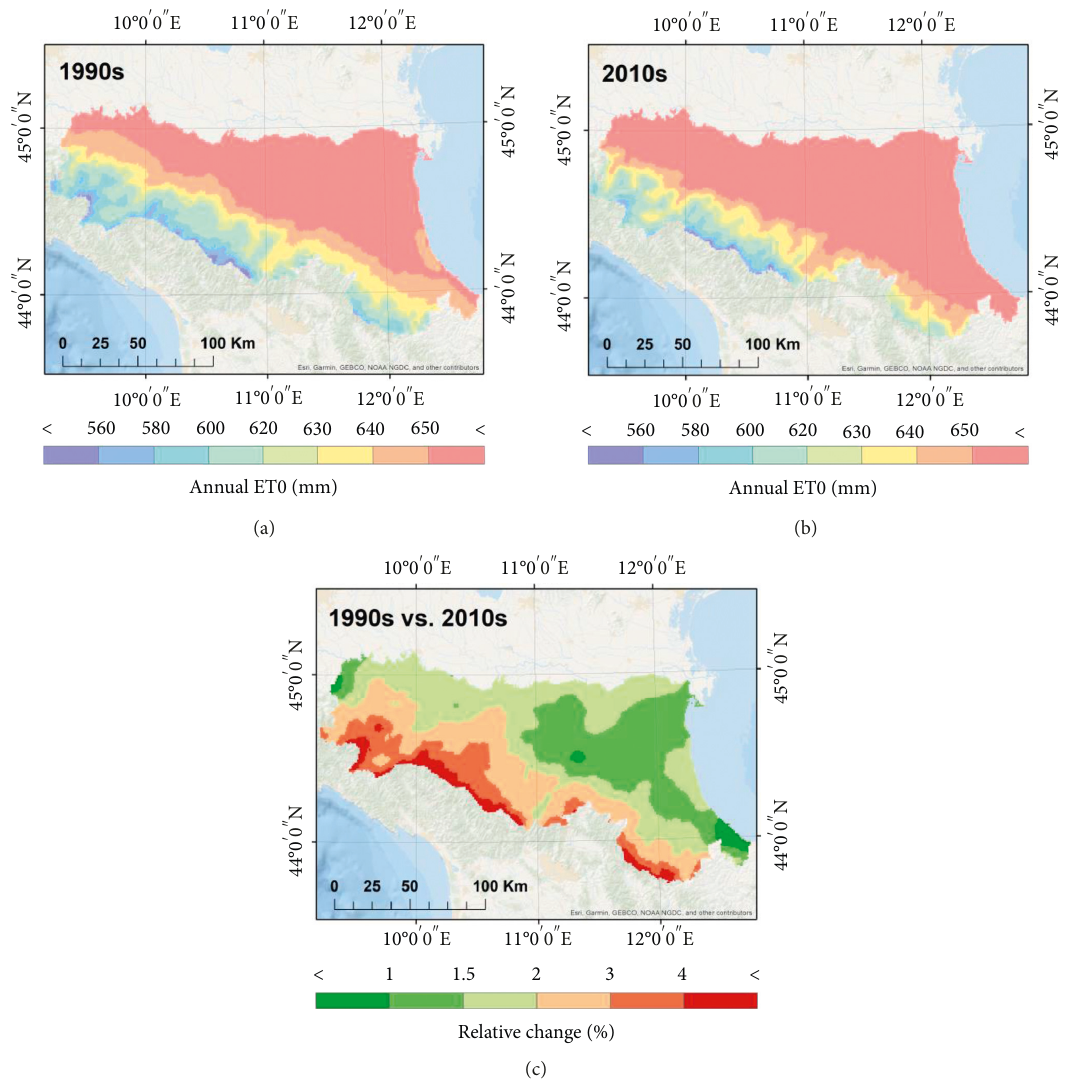
Figure 4: Spatial distribution of mean annual ET0. (a) The average of mean annual ET0 between 1961 and 1990. (b) The average of mean annual ET0 between 1991 and 2015. (c) The relative changes in mean annual ET0 as a difference between the two time-periods. Background image source: Esri, Garmin, GEBCO, NOAA NGDC, and other